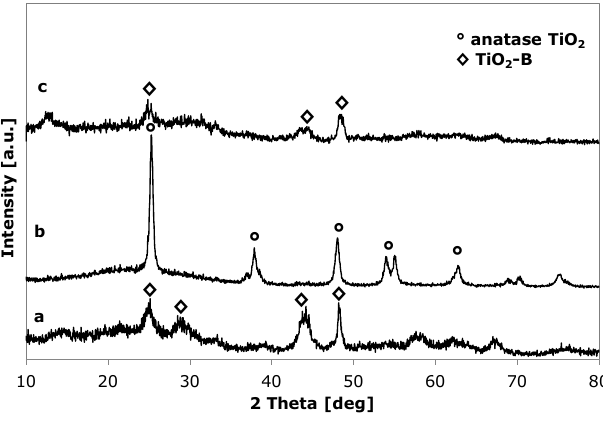
materials synthesized using (a) commercial TiO 2